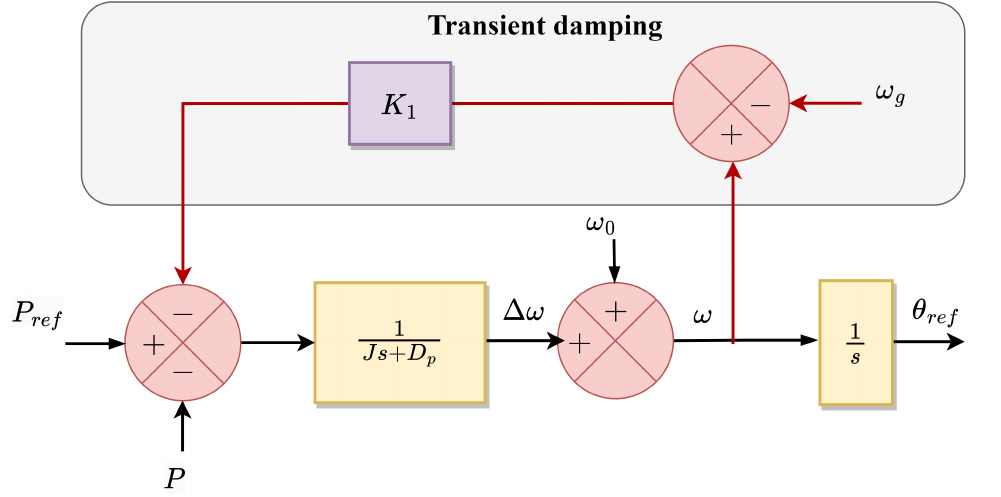
Figure 22. Proposed transient damping on the APC loop [120].